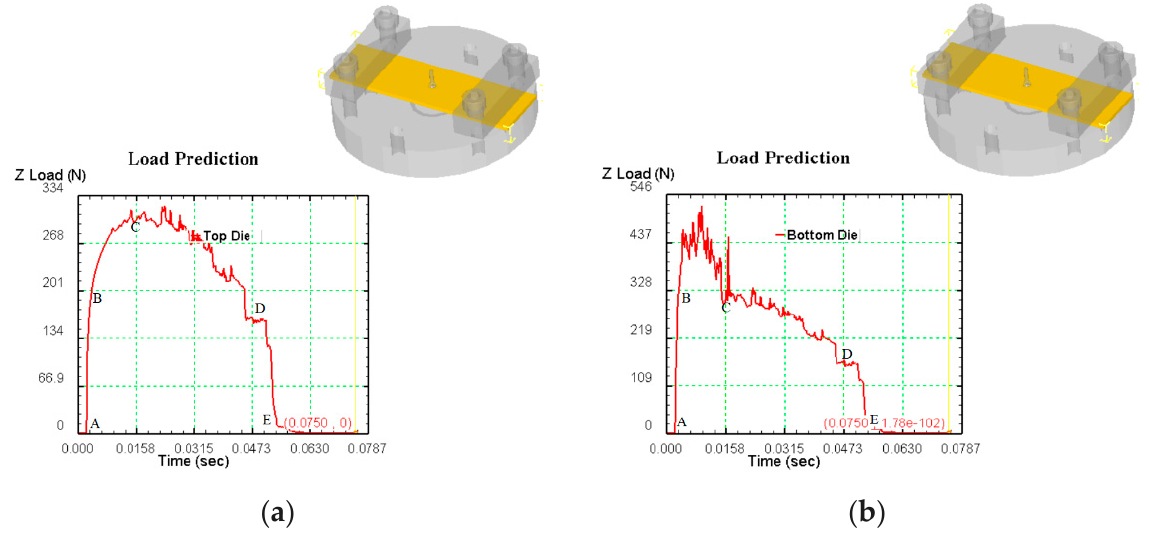
Figure 7. ( a ) The effective stress diagram of the punch in the simulation analysis of micro gear blanking; ( b ) The effective stress diagram of the die in the simulation analysis of micro gear blanking. Figure 7b is the effective stress diagram of the die in the simulation analysis of micro gear blanking. The blank of AB section is elastic deformation, and the blanking force increases approximately vertically in a short time until it reaches the yield strength of the blank. The blank produces yield deformation. At the beginning of BC section, the die stress transits from elastic deformation to plastic deformation step by step. At this stage, the die stress increases, and then decreases to C. At this point, the sheet metal is pressed into the die, and a large stress is generated at the contact edge of the die, and the stress value exceeds the shear strength. The blank begins to crack, the thickness of the blank joint decreases, the punch continues to move, the blanking force on the die gradually decreases,